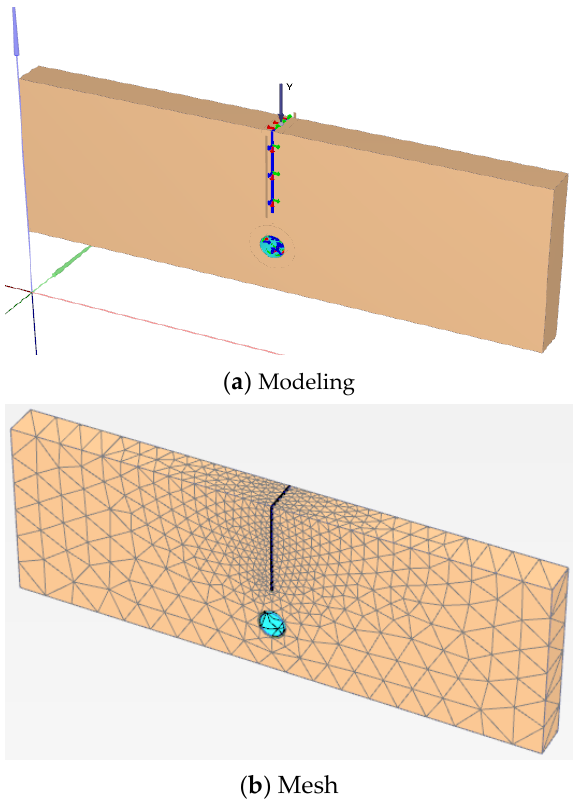
Figure 18. Modeling and mesh for 3D numerical analysis.